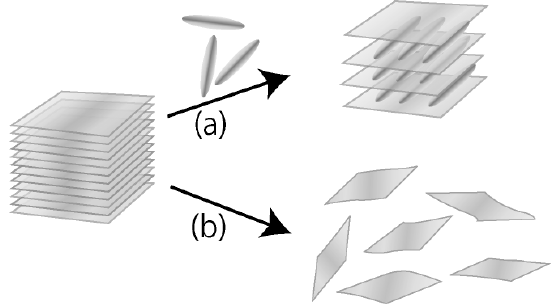
Figure 1. Schematic representation of: (a) intercalation and (b)